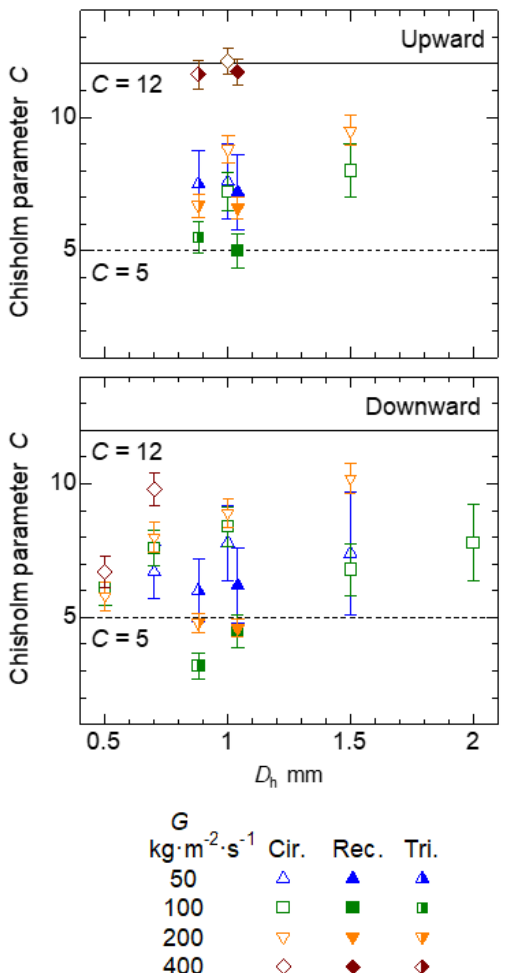
Figure 15. Optimum Chisholm parameter C by the measurement vs. hydraulic diameter D h